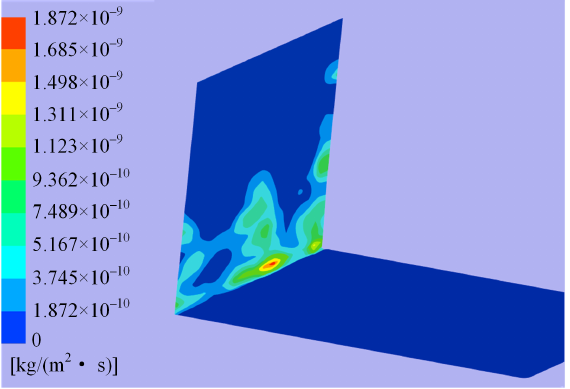
Figure 14. Erosion rates of the side wall of the deflector.